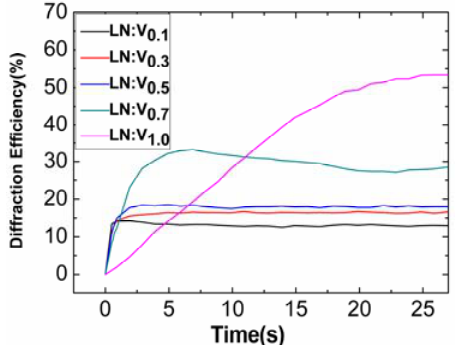
Figure 6. The time dependence of diffraction efficiency of LN:V crystals. The vanadium-doping concentrations are 0.1, 0.3, 0.5, 0.7 and 1.0 mol% for LN:V0.1, LN:V0.3, LN:V0.5, LN:V0.7 and LN:V1.0, respectively. The laser wavelength is 351 nm; the light intensities of the signal and reference beams are 283 mW/cm 2 and 300 mW/cm 2 [86].